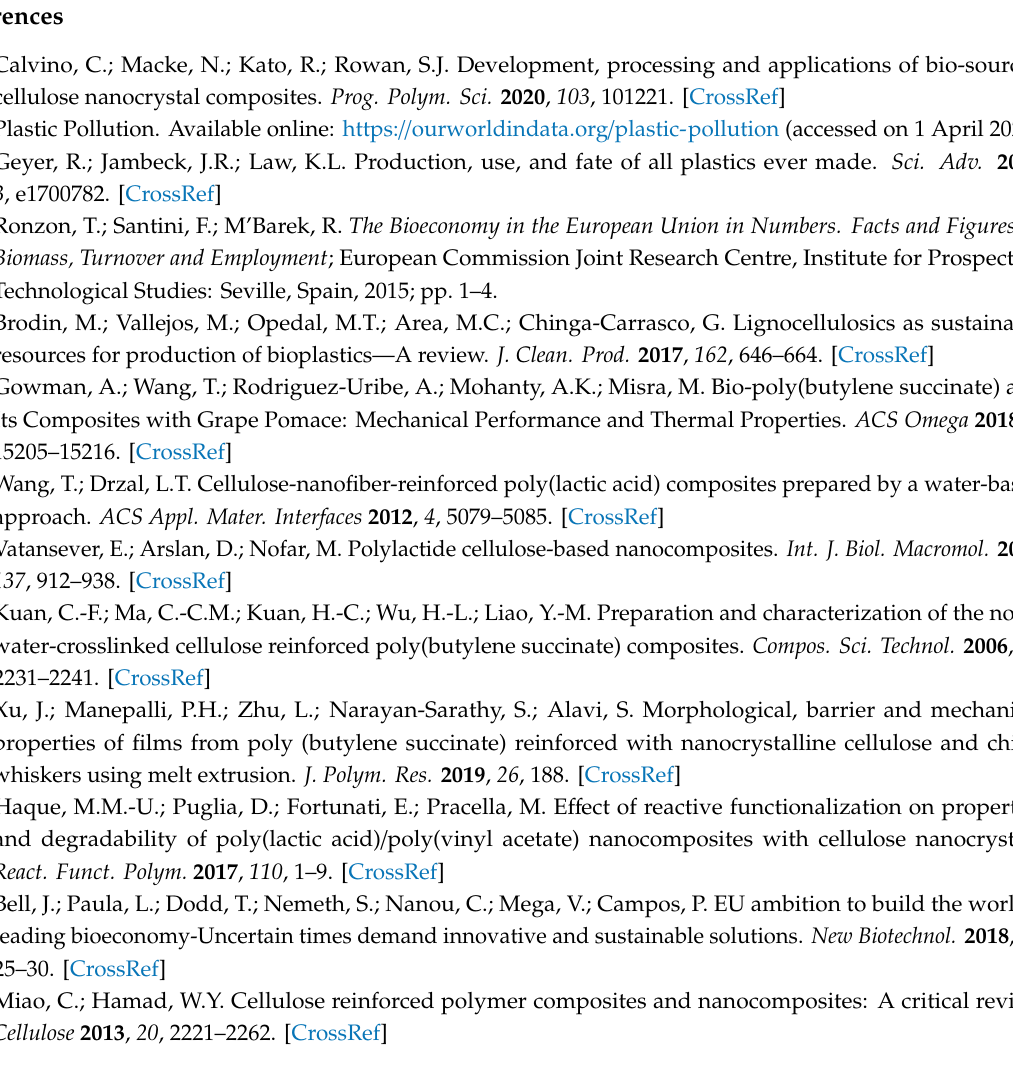
Figure S1: Example of the characteristic tensile curves of PBS / cellulose composites, Figure S2: Scanning electron microscopy micrographs: (a) PBS; (b) 40% NFC; (c) 7 / 3; (d) 5 / 5; (e) 3 / 7 and (f) 40% MCC, Figure S3: The measured contact angles: (a) 40% MCC; (b) 3 / 7; (c) 5 / 5; (d) 7 / 3; (e) 40% NFC and (f) PBS, Figure S4: Zisman plots: (a) 40% MCC; (b) 3 / 7; (c) 5 / 5; (d) 7 / 3; (e) 40% NFC and (f)